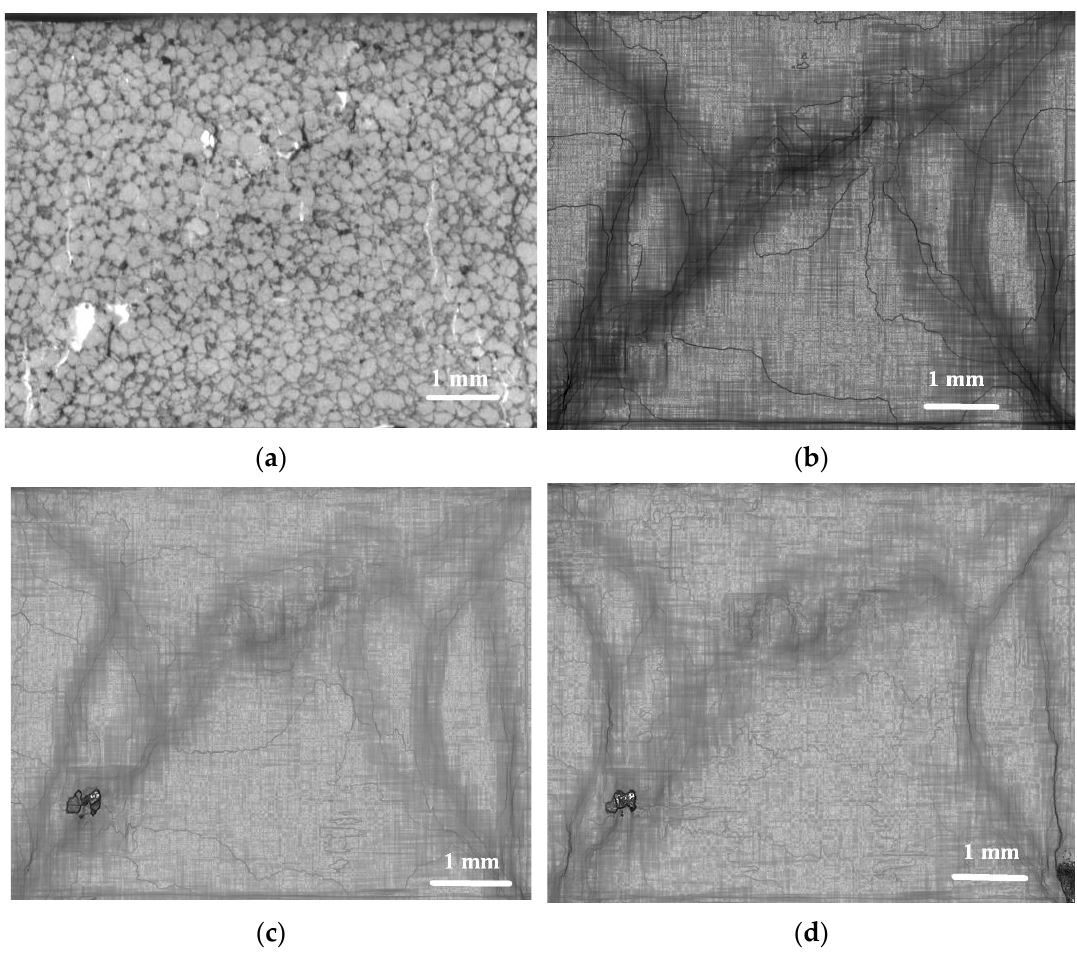
Figure 11. Optical macrograph ( a ) and deformation maps ( b – d ) of Sample #1 at the deformation Stage III at strain are as follows: ε = 0.072 ( a ), ε = 0.064, ∆ ε = 0.010 ( b ), ε = 0.067, ∆ ε = 0.010 ( c ), and ε = 0.072, ∆ ε = 0.010 ( d ).